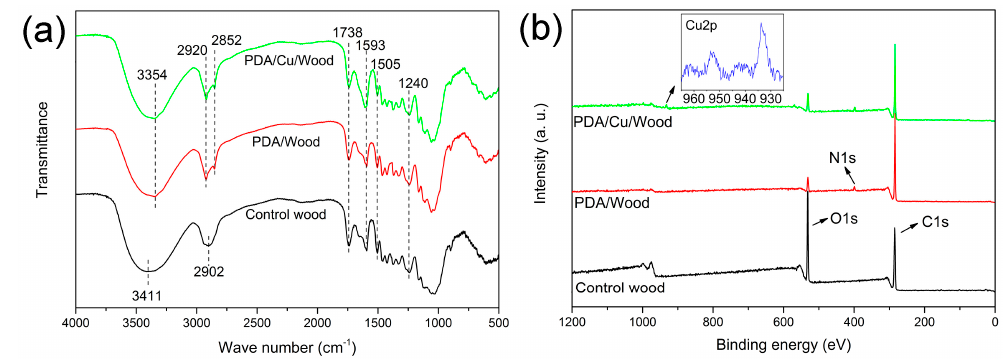
Figure 2. FTIR spectrum ( a ), and XPS spectra ( b ) for the control wood, PDA/Wood, and PDA/Cu/Wood samples, the inset picture is the Cu2p core-level spectra for PDA/Cu/Wood.